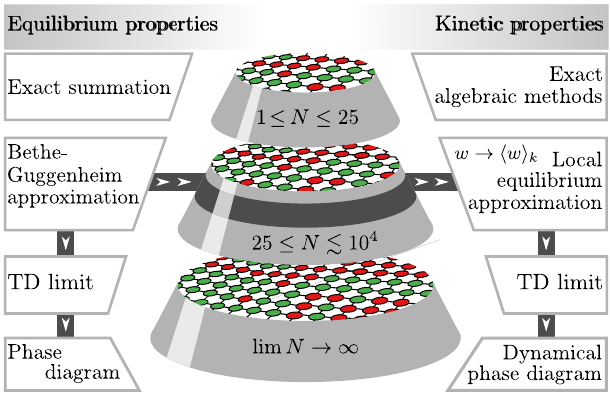
FIG. 2. Strategy roadmap. We exactly solve for small system sizes N ≤ 5 × 5 . The thermodynamics of larger systems is treated on the level of the highly accurate Bethe-Guggenheim approxi- mation and the kinetics by assuming local equilibrium. Within the Bethe-Guggenheim approximation, we take the TD limit N → ∞ and determine the phase behavior, master the scaling of dis- solution or formation kinetics, and analyze the statical and dynamical critical